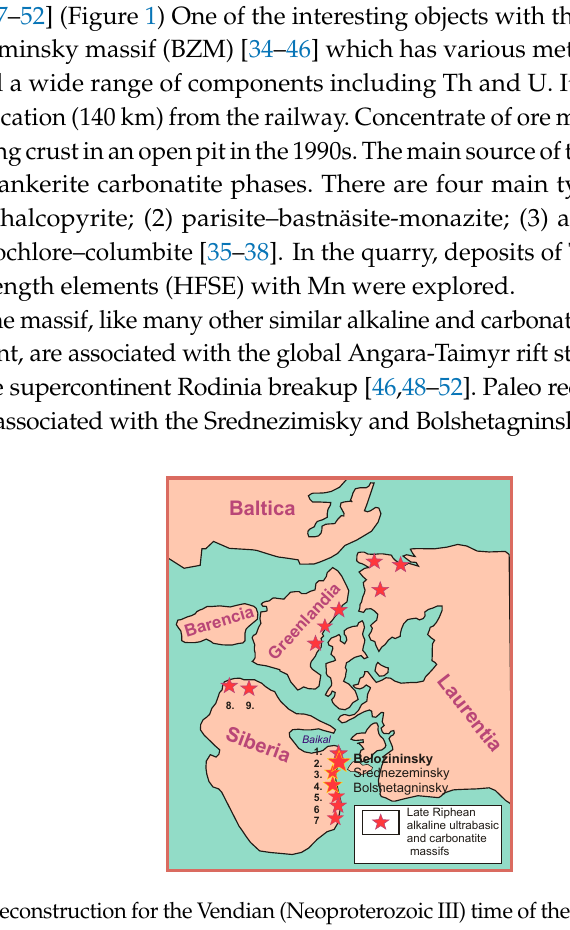
Figure 3. Geological scheme of the Nizhnesayansky alkali ultramafic carbonatite complex including Beloziminsky, Sredneziminsky; Bolshetagninsky massifs (redrawn from [35]).